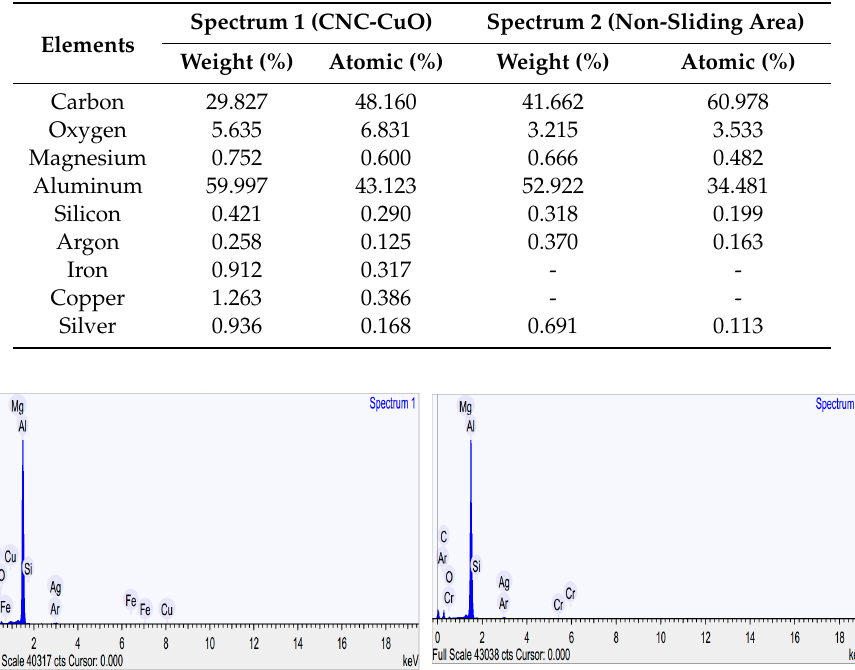
Figure 22. EDX spectrum of sliding and non-sliding contac.